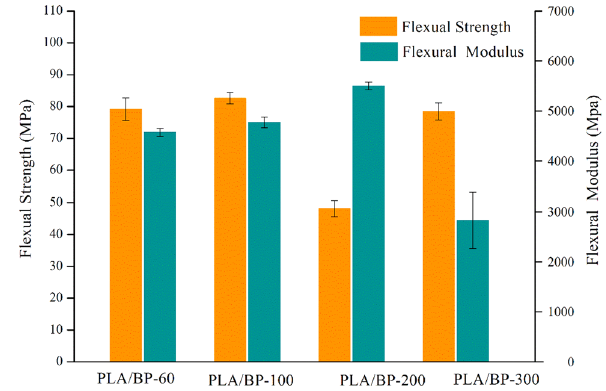
Figure 5: Flexural properties of PLA/BP biocomposites reinforced by BP with di ff erent